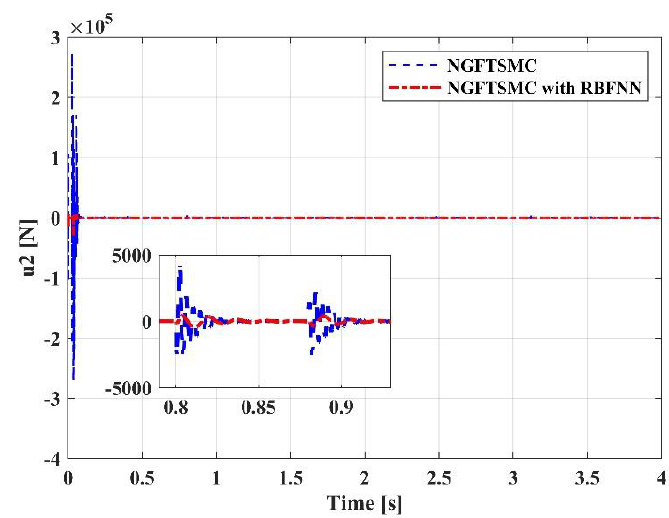
Figure 13. The performance of the control input 𝑢 2